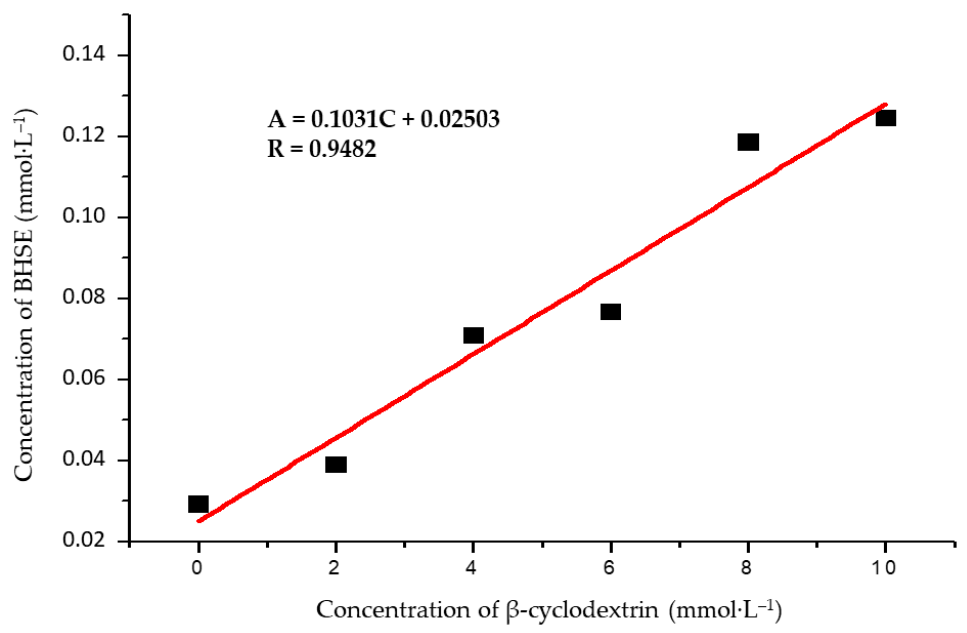
Figure 3. Solubility diagram of the BSHE: β -CD inclusion